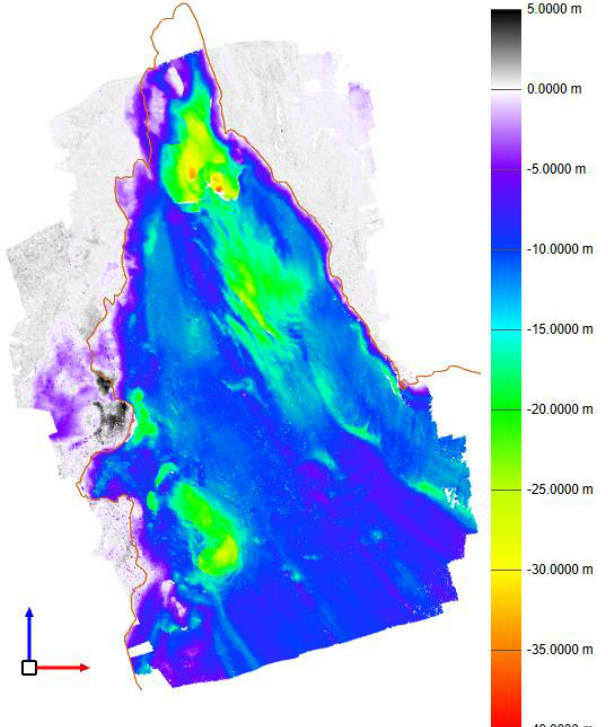
Figure 3. Height comparison map between 2014 DPC co- registered using CONFBLOCKS method and 2016 DPC.